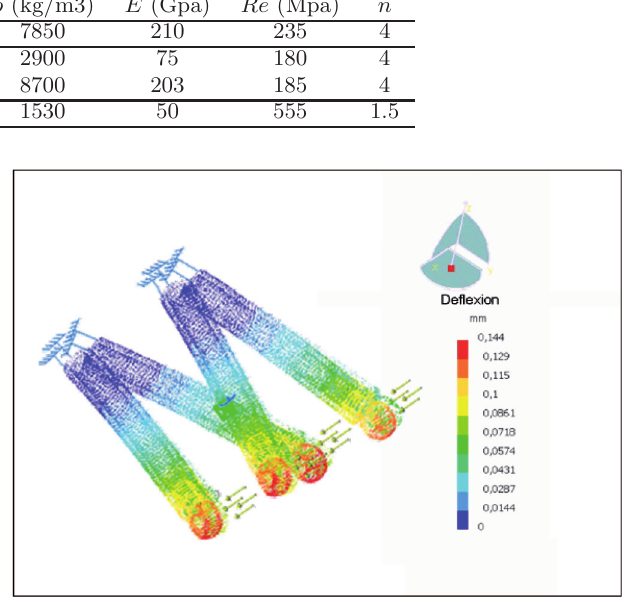
Fig. 7. Deflection representation using CATIA